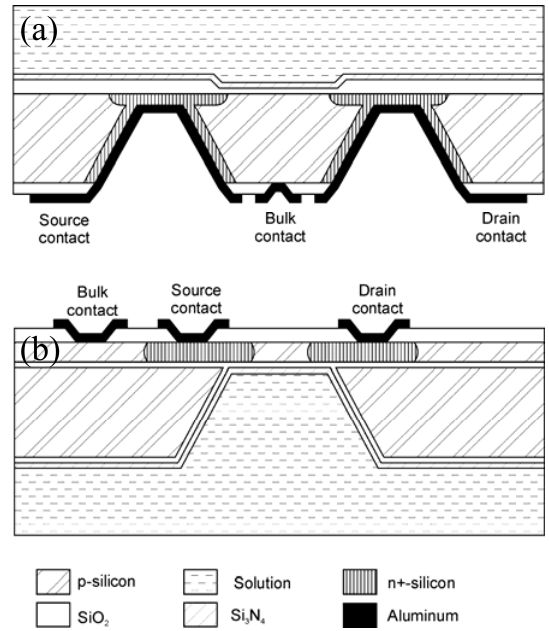
Figure 2. Cross-sectional schematic representation of back-side contacted